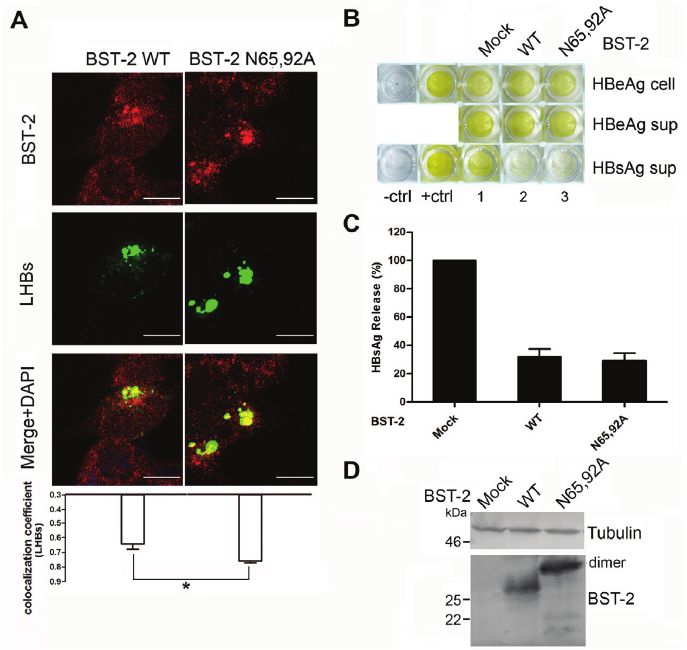
Figure 5. Stably-expressed BST-2 with mutated glycosylation sites significantly co-localizes with LHBs and potently inhibits HBV production. ( A ) 293T cells stably expressing BST-2 or its variants transfected with 1 µ g of LHBs-Flag were stained; blue, cell nucleus; green, LHBs protein; red, BST-2 protein. Images were taken under a Zeiss LZM710 confocal microscope. At least 30 individual cells were examined in each sample, and the most representative cells are shown. The co-localization coefficient (R) was calculated using Image-Pro Plus 6.0. Results were shown as mean ˘ SD. Statistical comparisons between the groups were performed by unpaired t -test using GraphPad Prism 5. * p < 0.05. Scale bars = 10 µ m; ( B ) 293T cells stably expressing BST-2 or its variants were transfected with 1 µ g of HBV proviral plasmid. HBV antigens in the cells and supernatants (sup) were detected by HBV antigen ELISA; ( C ) HBsAg release percentages of ( B ) are shown in columns; ( D ) BST-2 expression was detected by Western blotting.